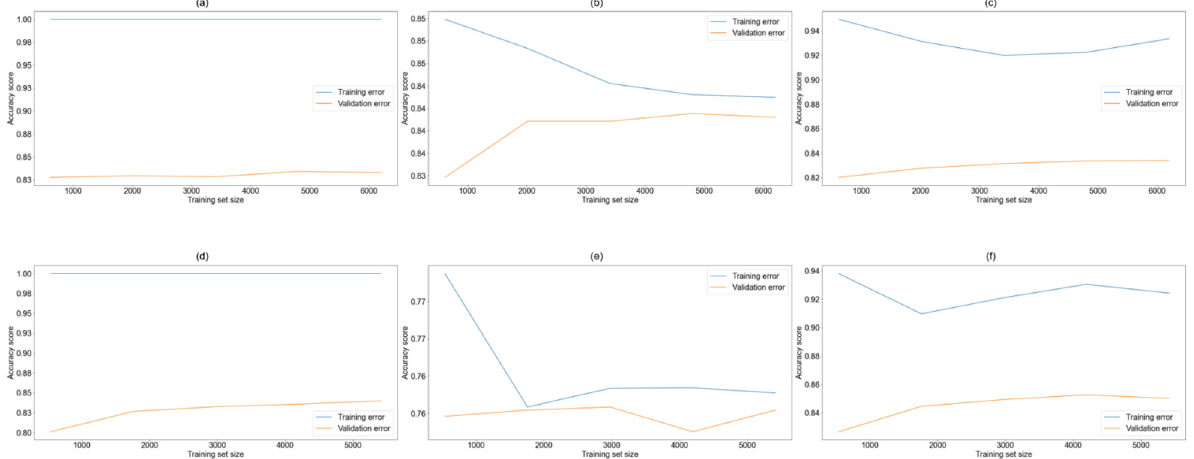
Figure 5. Training and cross-validation curves: ( a ) KNN with ethanol; ( b ) MLP with ethanol; ( c ) random forest with ethanol; ( d ) KNN with FC-72; ( e ) MLP with FC-72; ( f ) random forest with FC- 72.